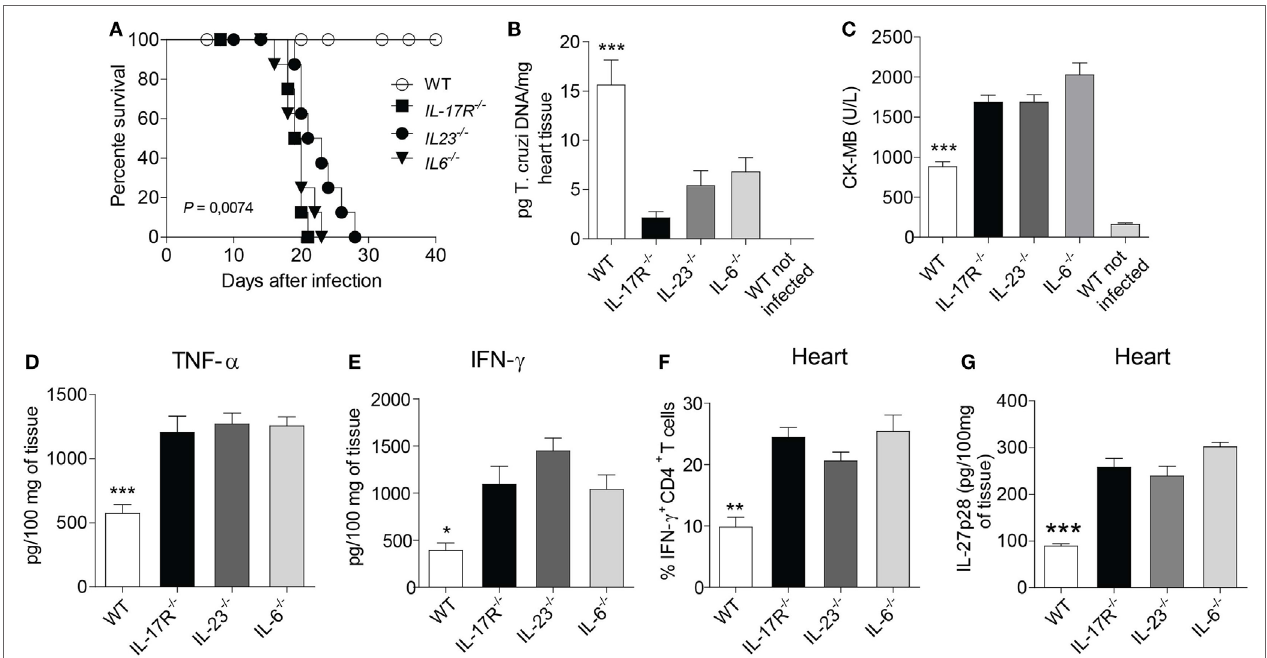
FigUre 1 | The absence of Th17-related molecules promotes intense recruitment of T H 1 cells and tissue damage in the heart. (a) After infecting wild-type (WT), IL-17R-, IL-23-, and IL-6-deficient mice with 10 3 trypomastigotes, the animal survival was daily assessed for 40 days. (B) Parasitism and cardiac damage were assessed by quantifying the parasite DNA with qPCR after 15 days of infection with Trypanosoma cruzi . (c) The serum levels of CK-MB were measured by commercial kits according to the manufacturer’s recommendations. (D,e) TNF- α and IFN- γ were measured by ELISA in the heart homogenate of infected WT and IL-17R-, IL-23-, IL-6-deficient mice after 15 days of infection. (F) The frequency of IFN- γ -producing CD4 + T cells in the heart tissue after 17 days of infection. Cells were obtained from heart, re-stimulated with PMA/Ionomycin for 6 h and subjected to intracellular staining for IFN- γ . Data were expressed as percentage of positive cells. (g) The production of IL-27p28 from 100 mg of heart tissue homogenate was assessed by ELISA. The data are representative of three independent experiments ( n = 5). Data are expressed as mean ± SEM ( P <